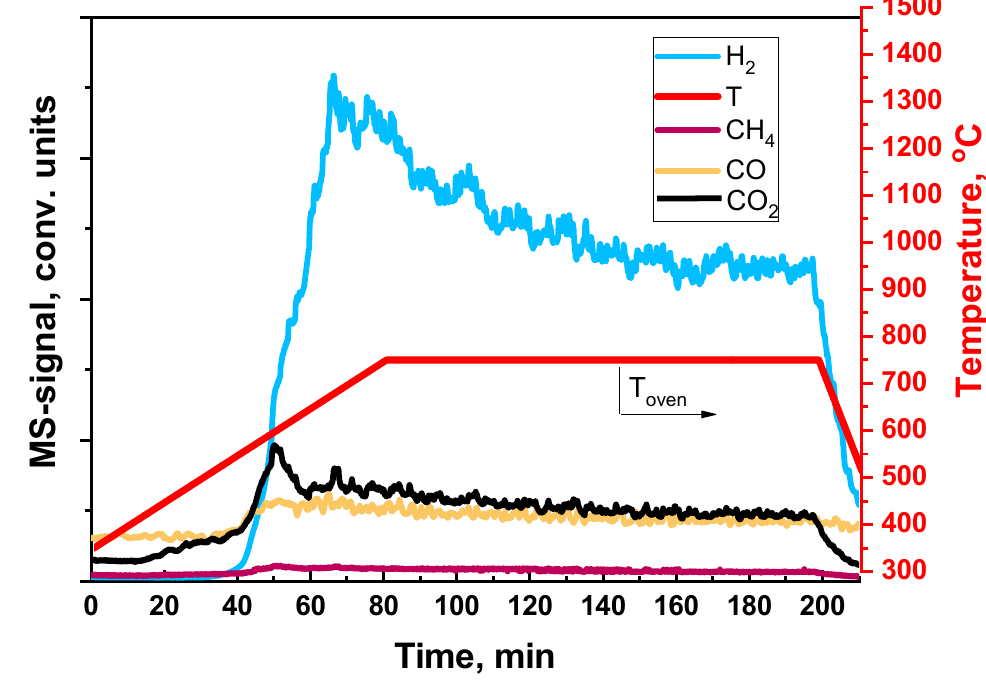
Figure 17. Removal of carbon, deposited on the Rh/CZB/FCA surface at DF ATR, by steam.